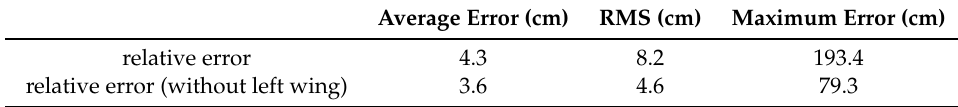
Table 2. Leica Pegasus 3D model accuracy assessment: relative error with respect to the TLS 3D model.